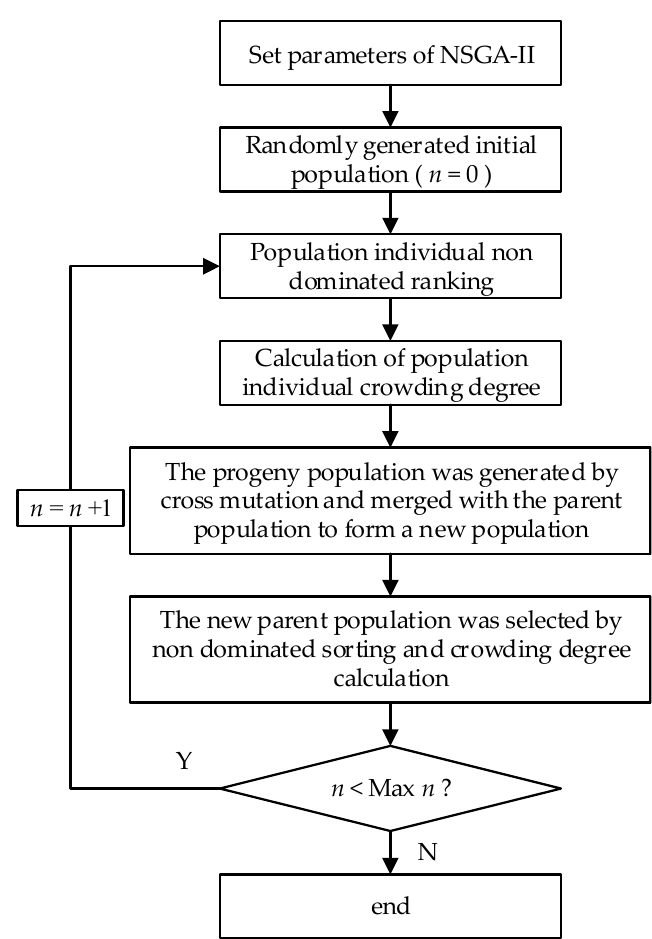
Figure 3. The flow chart of NSGA-II algorithm.